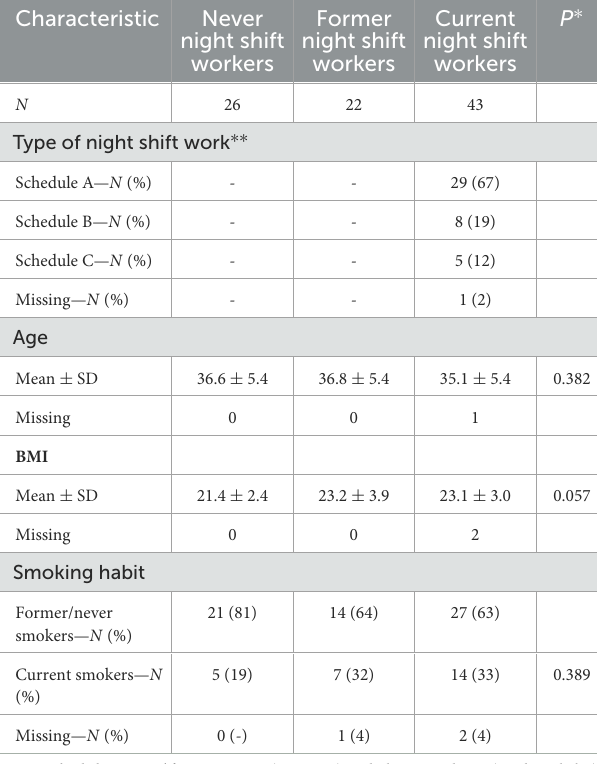
Former Current night shift night shift night shift workers workers